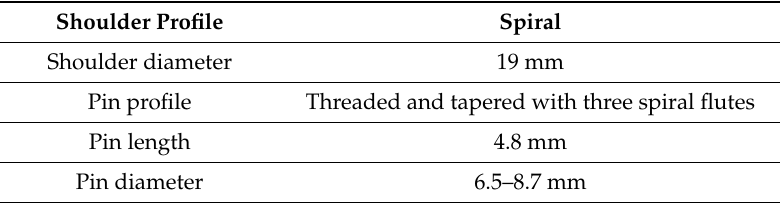
Table 3. The dimensions of the MX Triflute tool used.